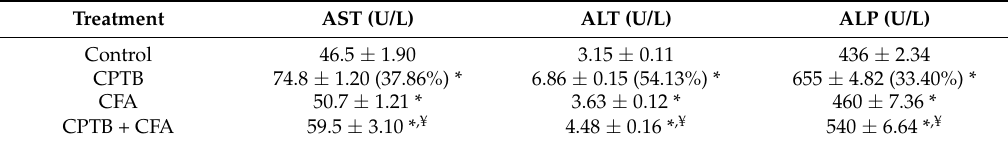
Table 2. Protective effects of caffeic acid on capecitabine-induced changes in the plasma activities of alanine aminotransferase (ALT), aspartate aminotransferase (AST), and alkaline phosphatase (ALP) in rats.